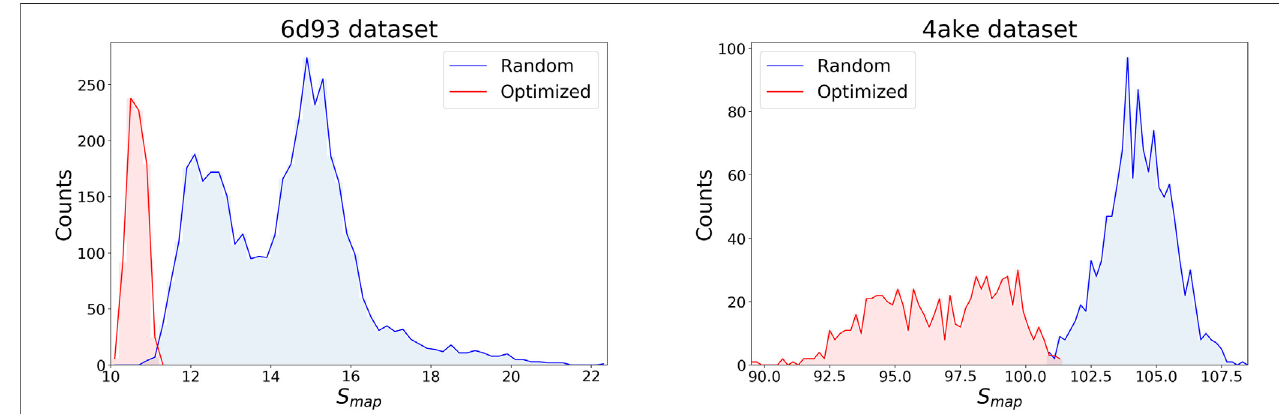
FIGURE 4 | Distributions of target values for both data sets, 6d93 (left) and 4ake (right) . For each protein, S map data are displayed in two distinct, non- overlapping histograms depending on their origin: blue curves are fi lled with random instances, while red histograms represent optimized CG mappings. All values of S map are in kJ/mol/K.